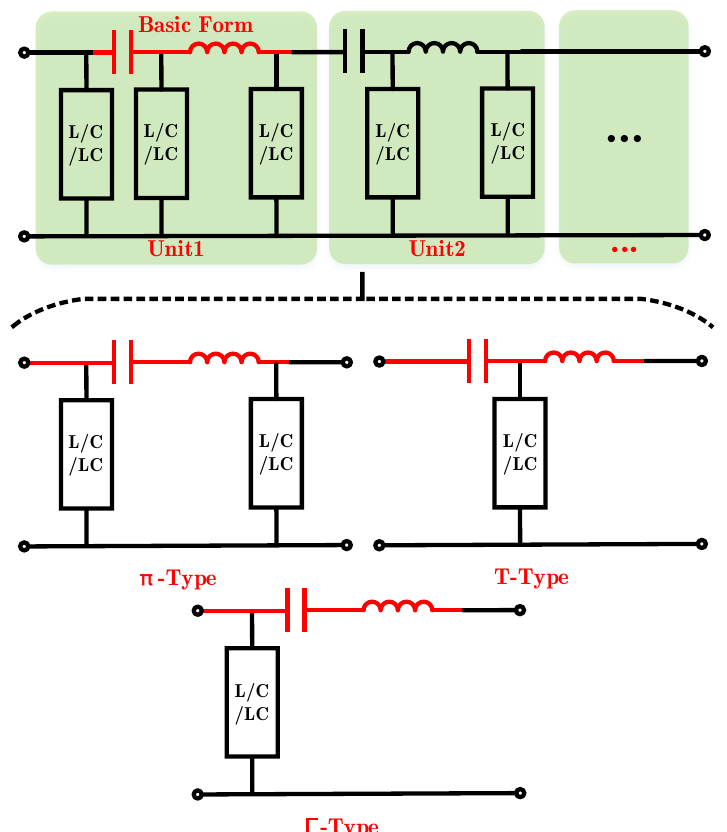
Figure 3. The composition of the bandpass filter.